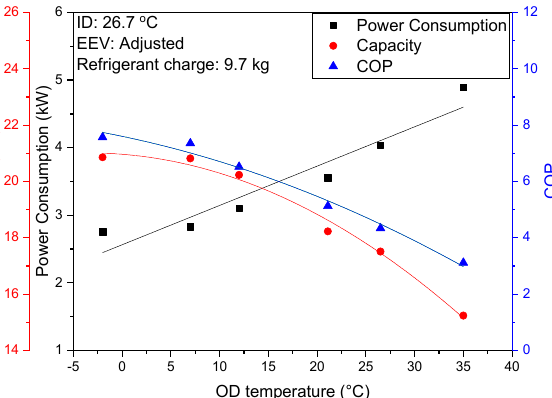
Figure 4. Performance variation of conventional cooling system according OD air temperature. From the graph, the COP and cooling capacity of the system increases with increases in OD temperature, while the power consumption decreases. The decrease in OD air temperature increases the mean temperature difference across the condenser of the cooling system, and this increases the heat rejection rate across the condenser between the refriger- ant and secondary air fluid. This results in an increase in subcooled refrigerant, as shown in Figure 5. The condensing and evaporating temperatures decrease as a result, from Figure 6, hence the mean temperature difference across the evaporator coupled with the subcooled refrigerant results in an increase in cooling capacity. The cooling capacity increases from 15.24 kW to 20.86 kW as the OD air temperature decreases from 35 ◦ C to − 2 ◦ C.